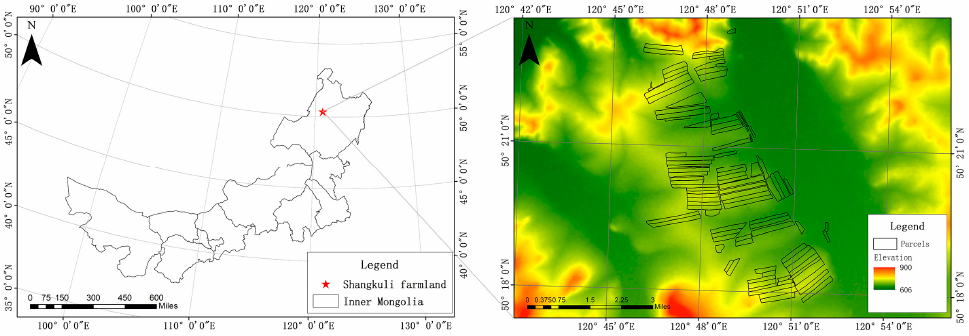
Figure 1. The location of study site and the oilseed rape parcels distribution in